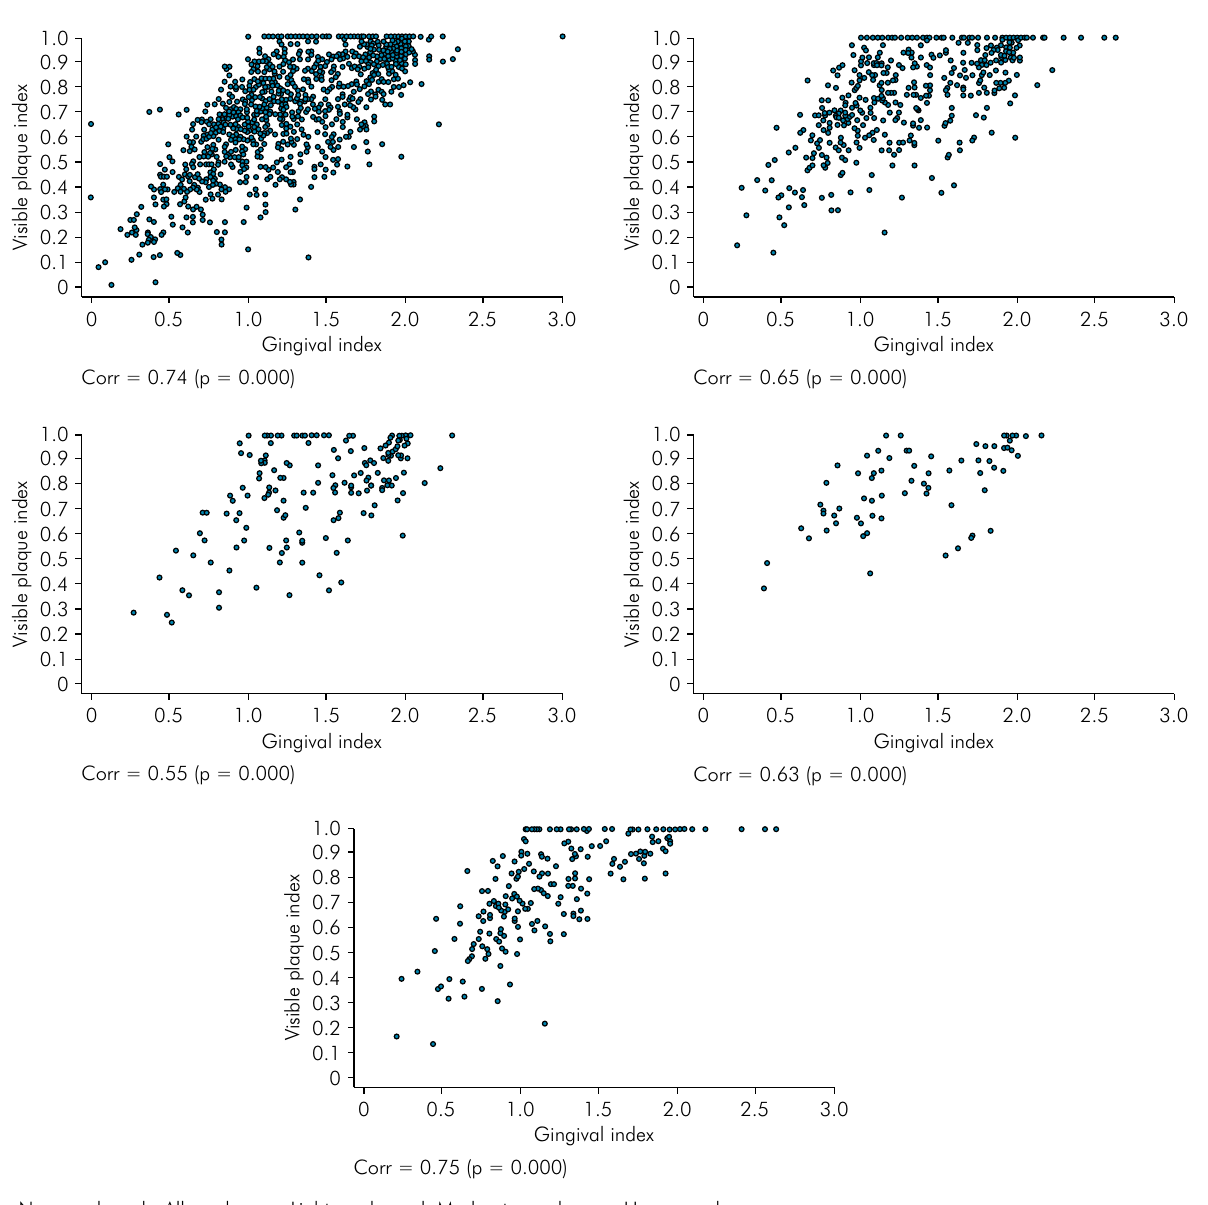
Figure. Correlations between VPl index and GI by smoking status